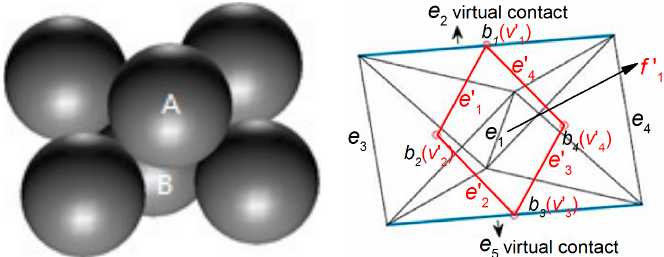
Figure 5. The pack of six particles ( left ) and its two dual geometrical systems ( right ). (v, e , f , b are the vertex, the edge, the face, and the body in the void cell system, respectively. v (cid:48) , e (cid:48) , f (cid:48) , b (cid:48) are the vertex, the edge, the face, and the body in the solid cell system, respectively.)